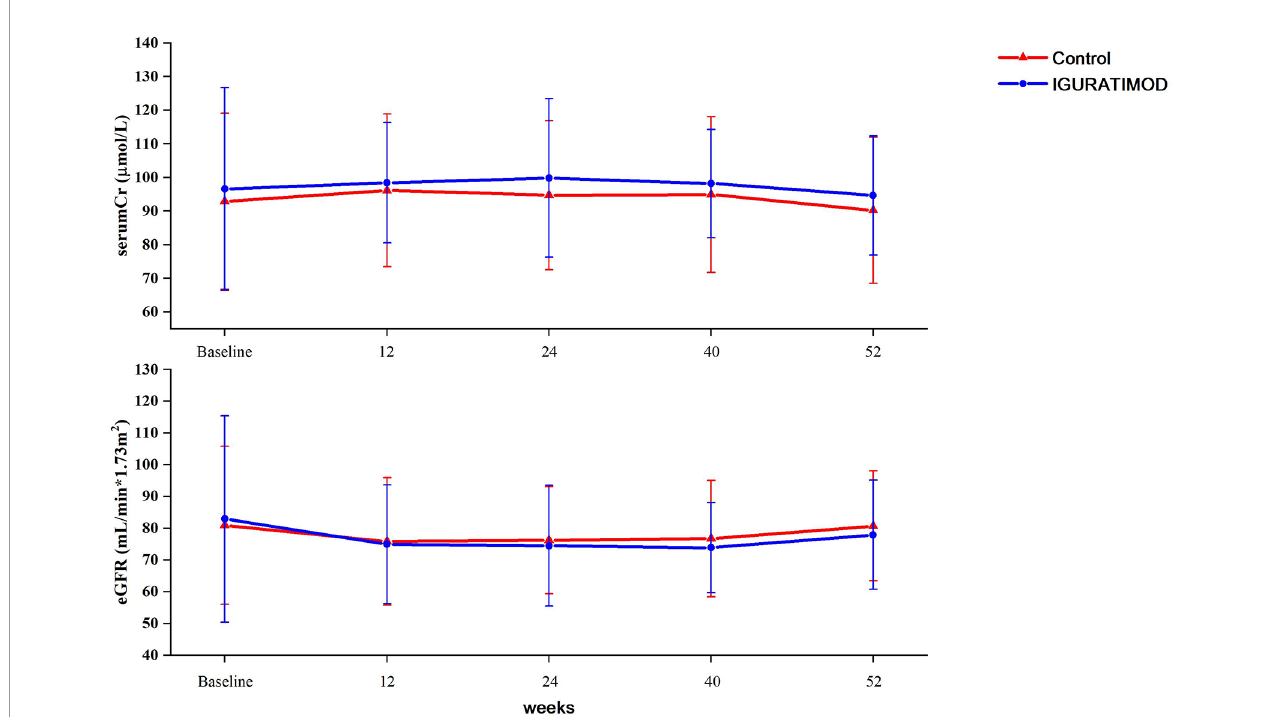
FIGURE 3 | Graft function between two arms. Serum creatinine levels were tested at baseline, 3 months (11~13 week), 6 months (23~25 weeks), 9 months (38~40 weeks) and 12 months (52 weeks). eGFRs were calculated using equation and adjusted to the BSA. Repeated measurement ANOVA method was used to compare the difference between groups. No statistical differences were reached either between two groups ( P = 0.47 for serum creatinine, and P = 0.79 for